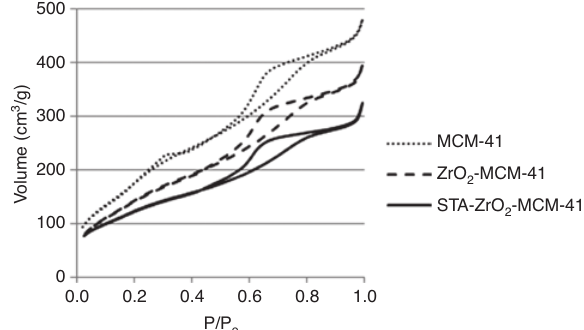
adsorption-desorption isotherms of MCM-41 supported 2